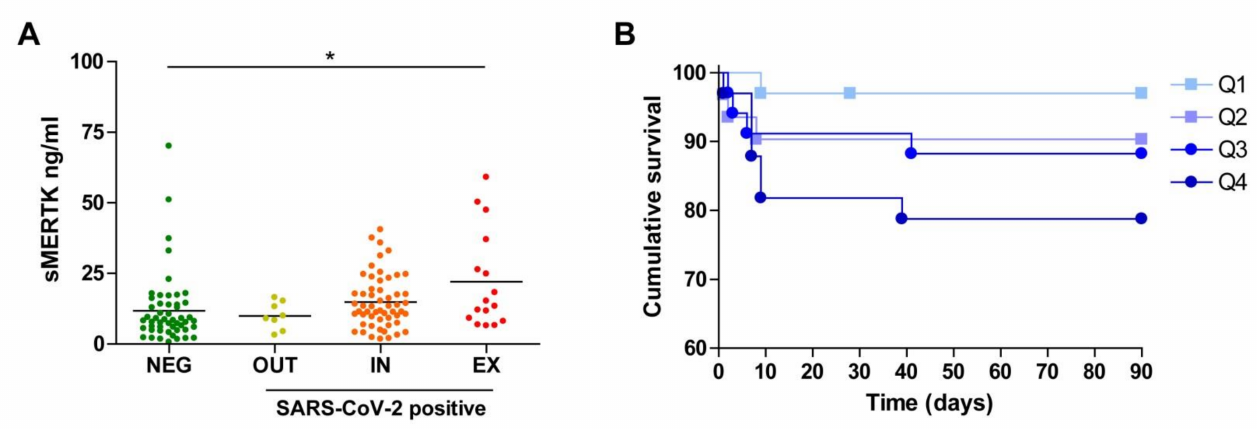
Figure 3. Plasma soluble MERTK(sMERTK) concentration in consecutive emergency patients and survival curves related to quartile MERTK values. ( A ) sMERTK plasma concentration was measured in all patients and compared using one-way Anova. *, p < 0.05. ( B ) Survival plot of all patients divided by sMERTK concentration quartile at admission. The MERTK survival curves were not different in a logrank test ( p = 0.154) and the Q4 survival was significantly different only to the Q1 curve ( p = 0.024 vs.